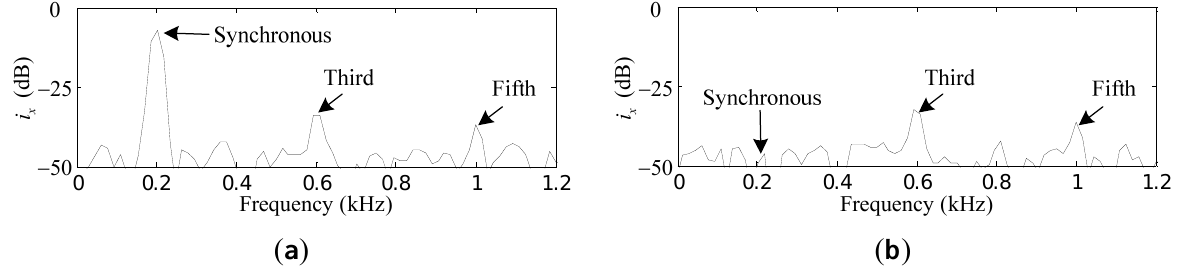
Figure 13. Simulation results of i x : ( a ) before synchronous current reduction; ( b ) after synchronous current reduction.